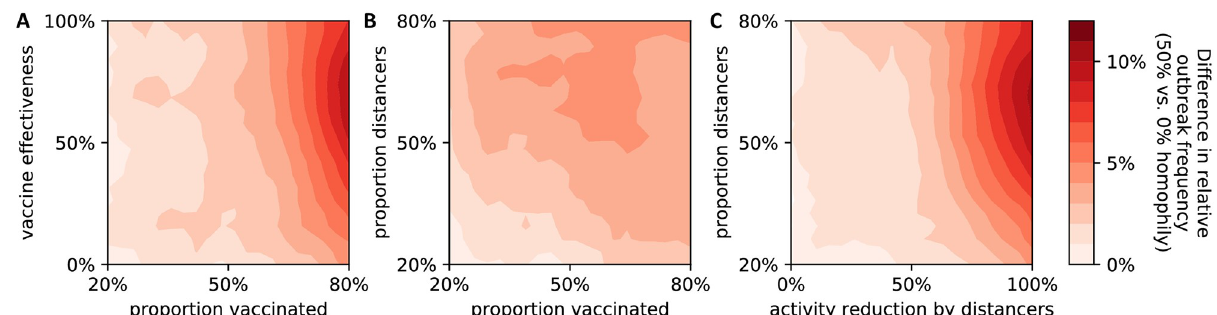
Fig 2. Comparison of outbreak frequency in networks with and without homophily. Contour plots were generated from 10,000,000 independent simulation runs with four vaccine and social distancing parameters chosen uniformly at random (axes show parameter ranges). The difference in outbreak frequency (where an outbreak was defined as > 1% of the population eventually becoming infected) from a reference scenario of no vaccine and no social distancing was calculated for two scenarios: social interaction networks with 50% homophily of those who vaccinate and of those who practice distancing and networks without homophily (see S1 Fig). Data was binned and smoothed using a two-dimensional Savitzky-Golay filter [18] (details in Methods). Each subplot shows the effect of variation of two parameters on the difference in outbreak frequency between the two different homphilly scenarios (see S1 Fig). (A) vaccine coverage (x-axis) and vaccine effectiveness (y-axis), (B) vaccine coverage (x-axis) and proportion of those who distance, (C) contact reduction (in %) by those who practice social distancing (x-axis) and proportion of those who distance (y-axis). An equivalent analysis for the basic reproductive number is shown in S2